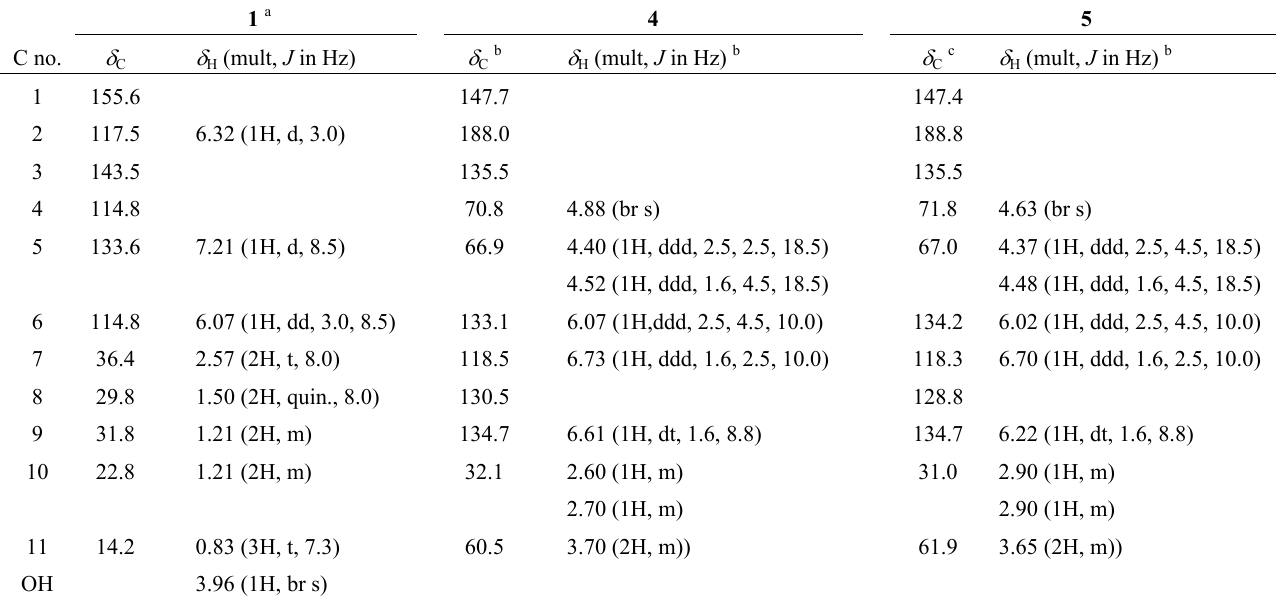
Table 1. 1 H- and 13 C-NMR data for compounds 1 , 4 and 5